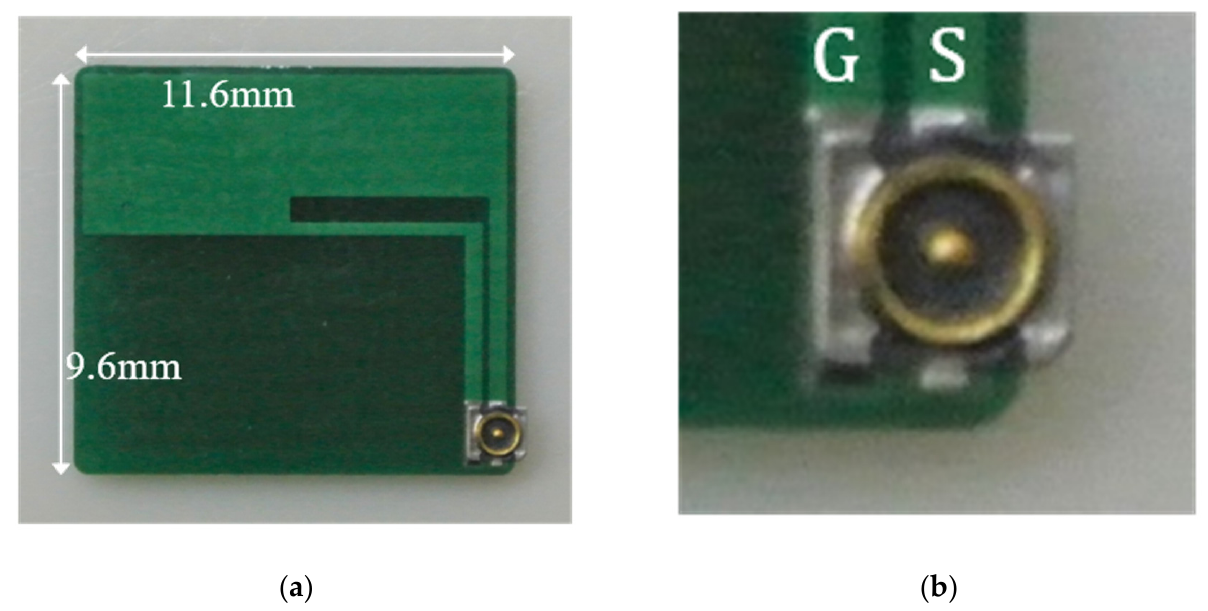
Figure 4. Photograph of the prototype board: ( a ) antenna element and ( b ) connection section.